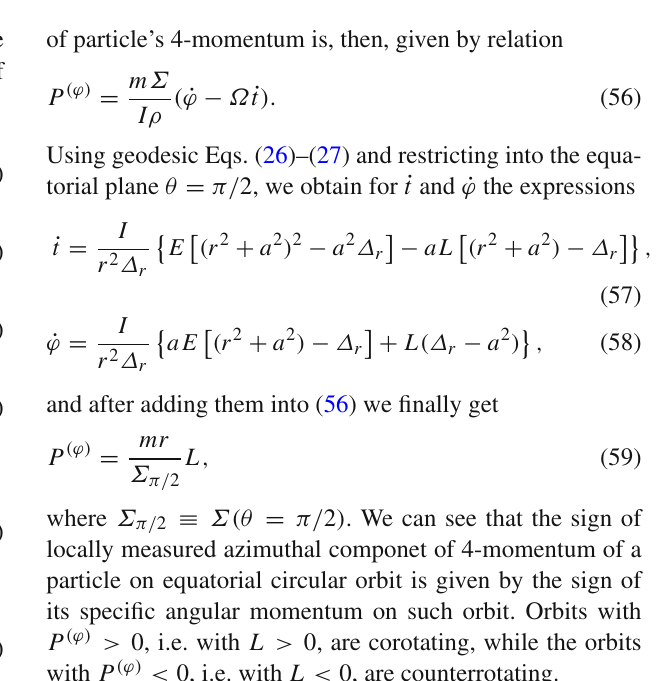
Fig. 5 Characteristic regions of existence of the equatorial circular orbits of the plus ( + ) and minus ( − ) families in the KNdS spacetimes. Solid curves correspond to circular photon orbits of a given family. Dashed lines and dotted curves determine static radii and horizons of